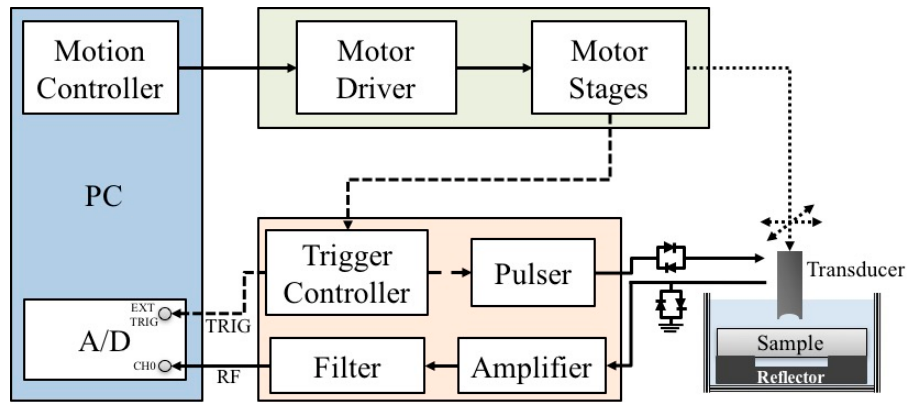
Figure 1. Block diagram of the experimental arrangement. Table 1. Characteristics of the applied transducer.